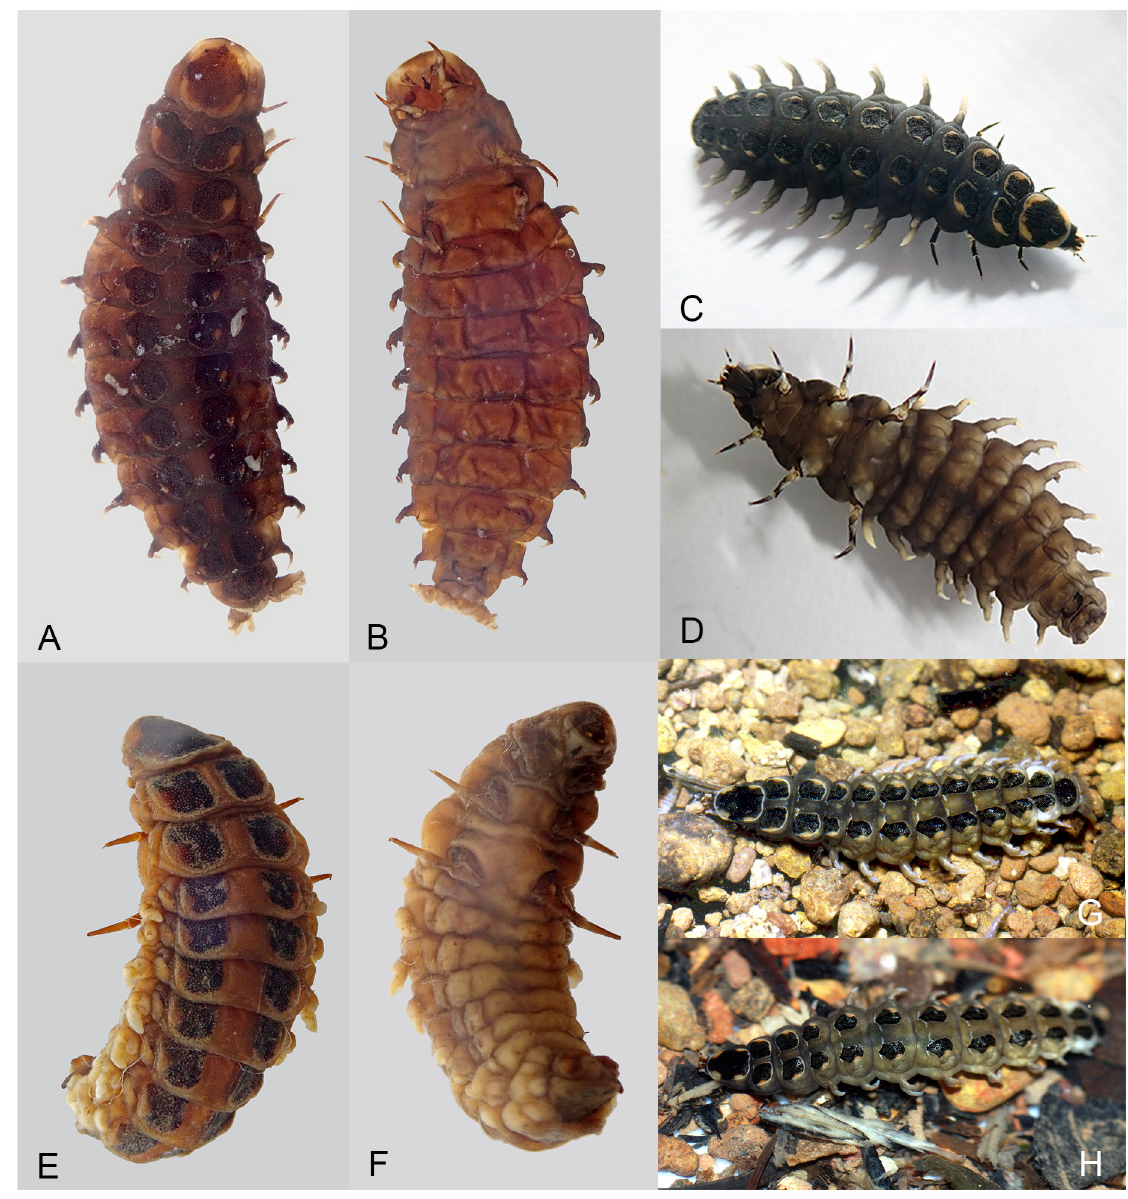
Fig. 9. Larvae. A–D . Nipponoluciola cruciata (Motschulsky, 1854) gen. et comb. nov. E–H . Nipponoluciola owadai (Satô & Kimura, 1994) gen. et comb. nov. A, C, E, G–H . Dorsal view. B, D, F . Ventral view. Images by I. Kawashima (A‒F) and F. Satou (Kumejima Firefly Museum)